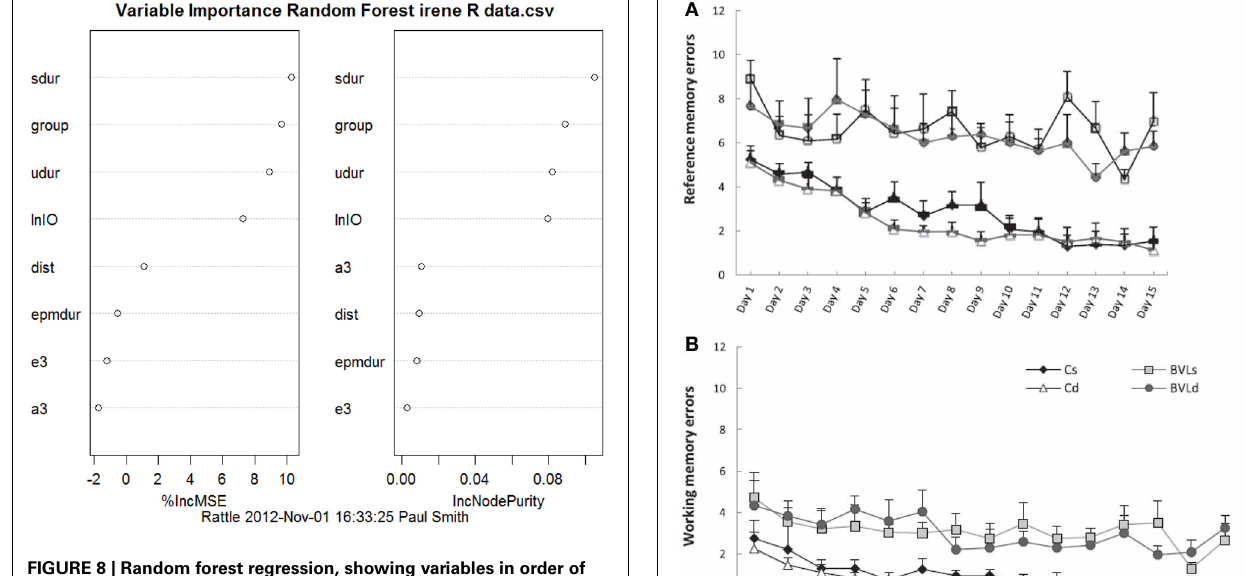
FIGURE 8 | Random forest regression, showing variables in order of importance from the top to the bottom, to predict the performance of BVD and sham animals in a spatial T maze task from the animals’ performance in other behavioral tasks, such as the elevated plus maze, the open field maze and the elevated T maze. “group:” whether the animals had received a BVD or a sham operation. “epmdur:” duration of open arm entries in the elevated plus maze. “lnIO:” the ln of the ratio of time spent in the inner/middle to the outer zones of the open field maze. “e3:” 3rd escape latency in the elevated T maze. “a3:” 3rd avoidance latency in the elevated T maze. “dist:” distance traveled in the open field maze. “sdur:” duration of supported rearing in the open field maze. “udur:” duration of unsupported rearing in the open field maze. Reproduced with permission from Smith et al. (2013).